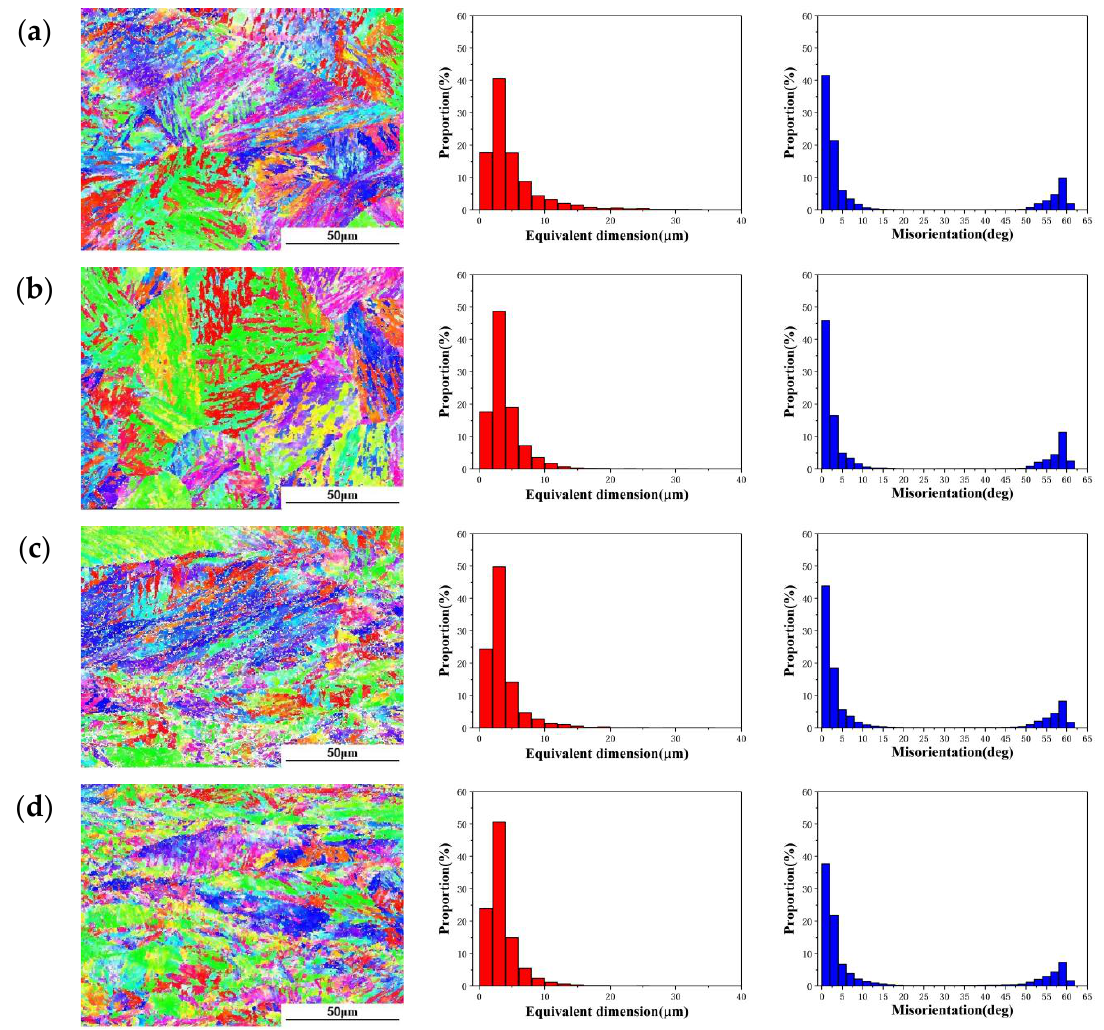
Figure 10. The distribution and dimensions of the martensite lath and the distributions of grain boundary misorientation after heat treatment: ( a ) 15%; ( b ) 30%; ( c ) 45%; ( d ) 60%.